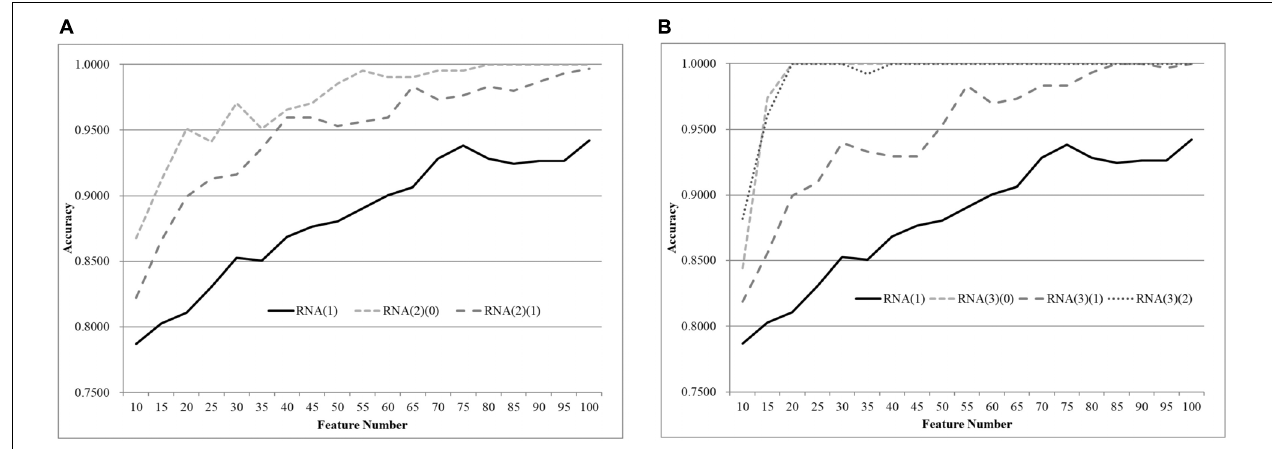
FIGURE 3 | Comparison of early-stage breast cancer detection models with different age groups based on transcriptome data. The patients were split into (A) two groups and (B) three groups with equally-sized age ranges. The horizontal axis shows the numbers of features chosen by rfeSVM and the vertical axis shows the 10-fold cross validation accuracy of the classifier SVM. F -test was used to generate the initial subset of the 1000 top-ranked features.